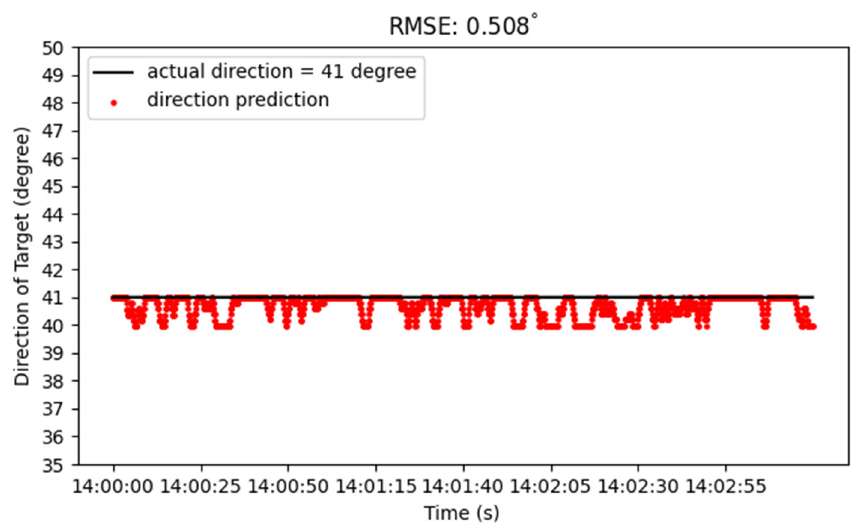
Figure 15. Single station measurement result in the urban environment.